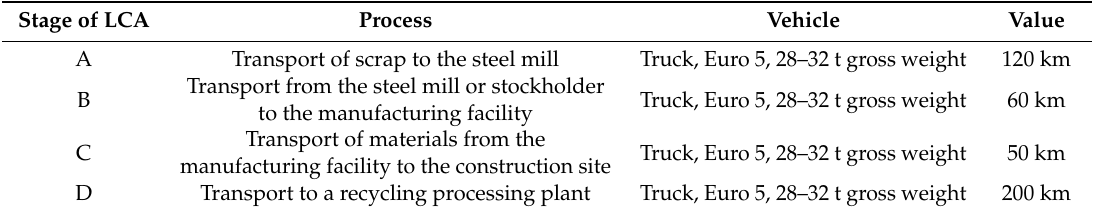
Table 3. Reference values for